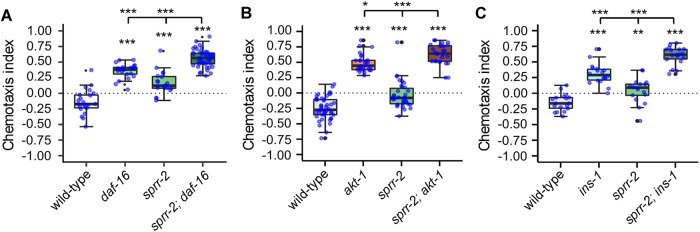
MIP-signaling mediates salt avoidance learning in parallel with the insulin pathway.(A) sprr-2 does not genetically interact with daf-16 to regulate salt avoidance learning as sprr-2; daf-16 double mutants show further impaired learning as compared to the single mutants. (B) sprr-2; akt-1 and (C) sprr-2; ins-1 double mutants also show a significantly enhanced learning defect as compared to their respective single mutants. Individual CIs are plotted as blue dots. Boxplots indicate 25th (lower boundary), 50th (line), and 75th (upper boundary) percentiles. Whiskers show the minimum and maximum values. Outliers are indicated as black dots. Data were analyzed by one-way ANOVA and Tukey post-hoc test (n ≥ 17). *p<0.05, **p<0.005, ***p<0.001.